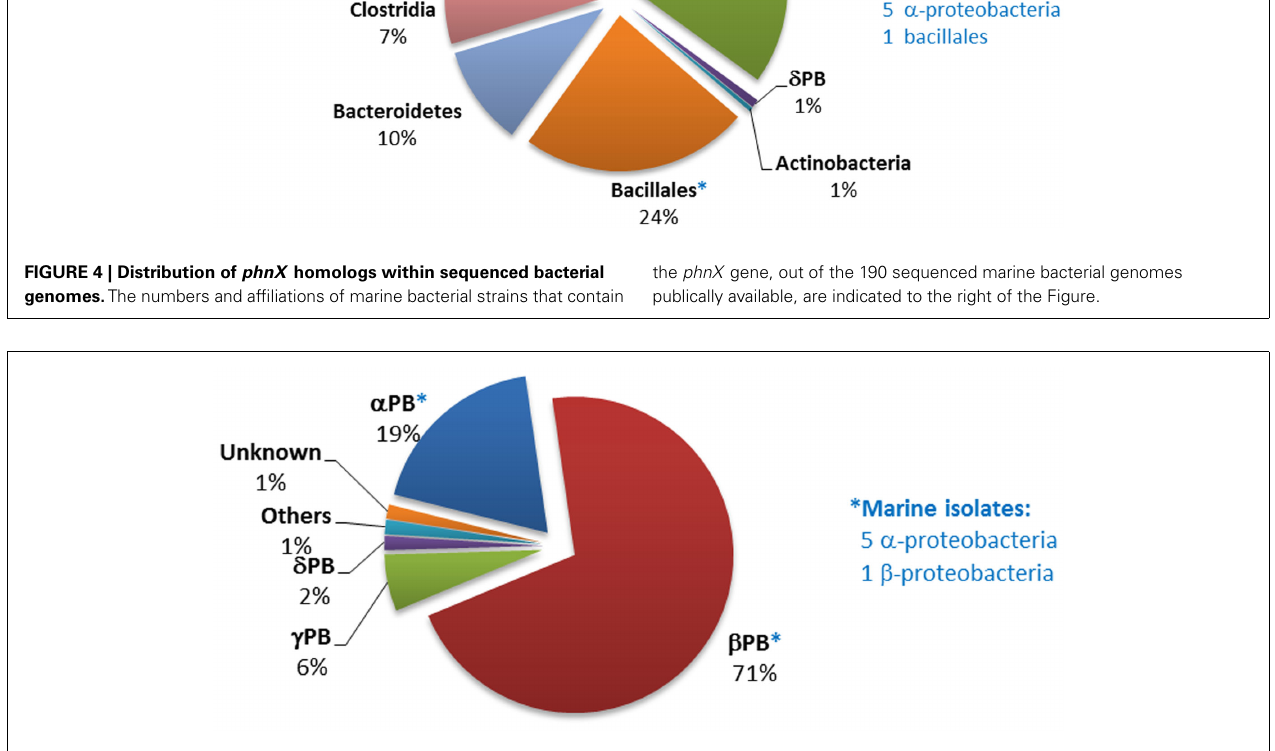
FIGURE 5 | Distribution of phnA homologs within sequenced bacterial genomes. The numbers and affiliations of marine bacterial strains that contain